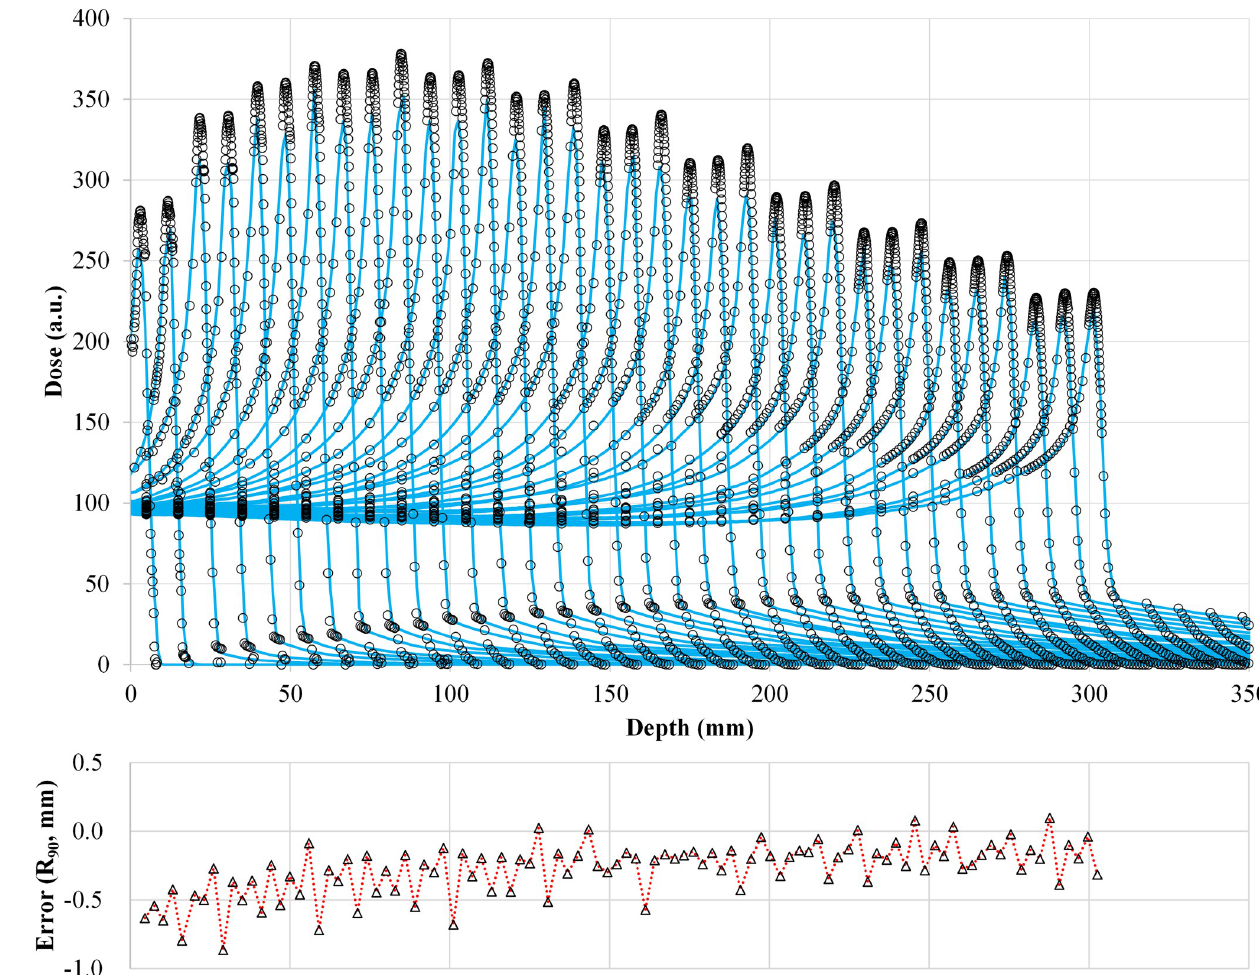
Fig 3. Comparison of IDDs from the TPS calculations and measurements for 100 energies. The circles and solid lines show the measured and calculated IDDs, respectively. IDDs were selected for ease of viewing. The lower graph shows the differences in R 90 in units of millimeters for all energies.